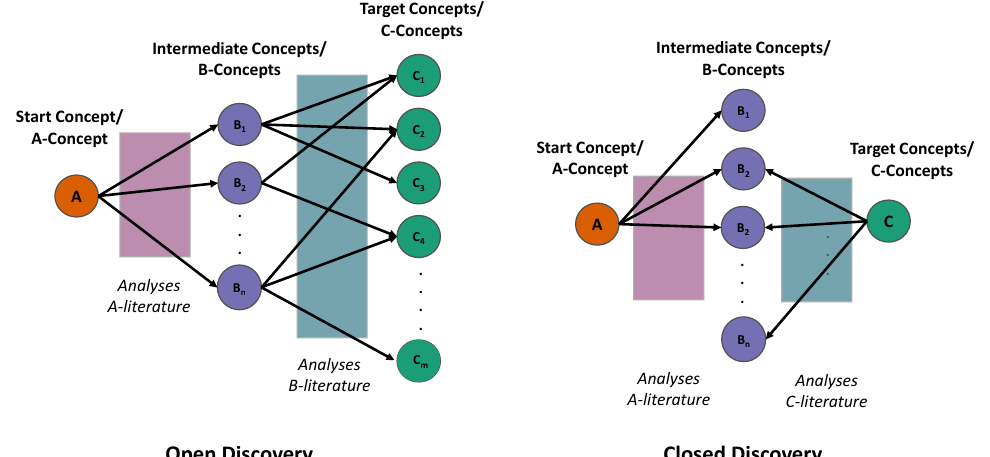
Figure 2. Swanson’s LBD ABC Model in its open ( left ) and closed ( right ) discovery modes (figure from our previous work [8]). The model relates concepts found in two disjoints bodies of scientific literature by identifying connecting b-concepts found in both collections. In the open discovery mode, an initial, user-provided term is used to find related c-concepts. This mode is purely exploratory, and it is typically employed in the task of hypothesis generation. Differently, in the closed discovery mode, the user provides an a-concept and a c-concept to detect intermediate related b-concepts, generally to validate hypotheses. Our approach employs both modes to explore inter-domain affinities between elements in different bodies of